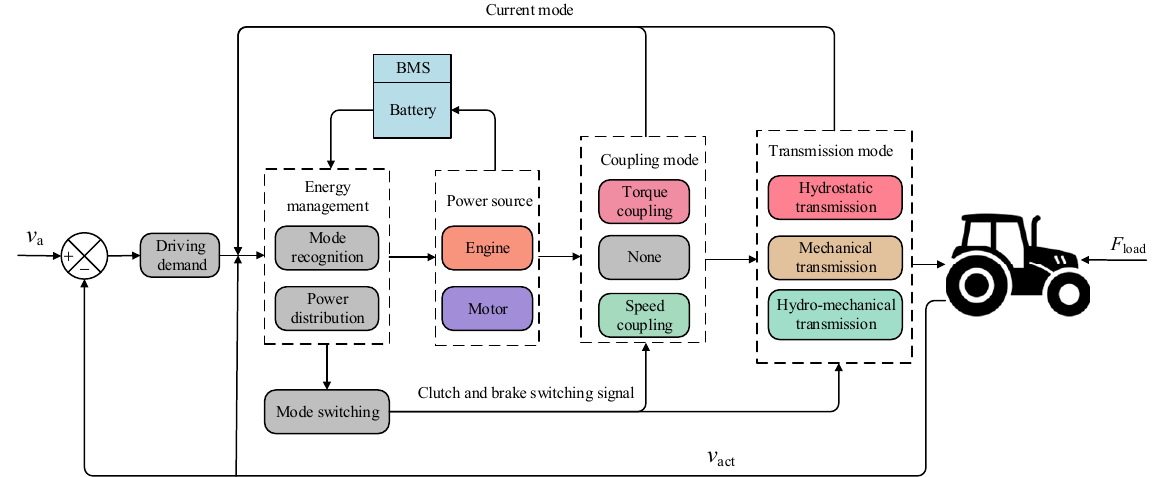
Figure 8. Tractor overall control architecture.